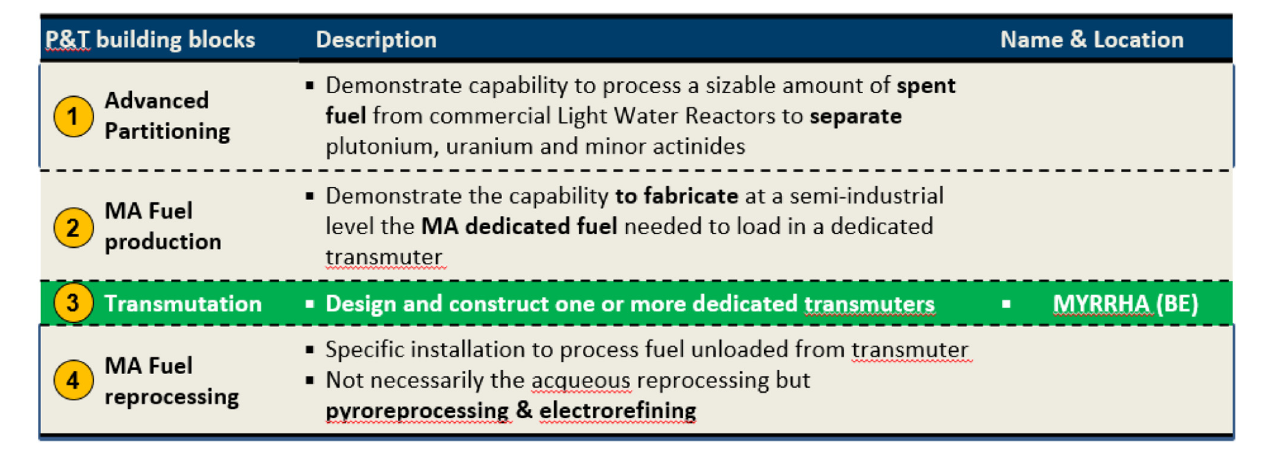
Table 1. P&T building